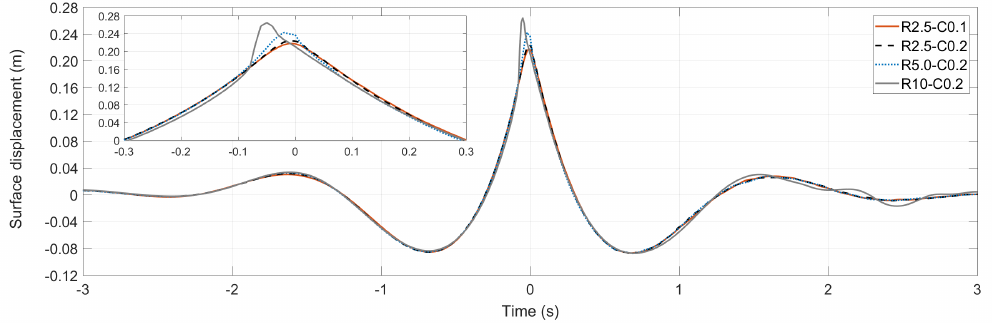
Figure 3. Convergence analysis for the NWT in